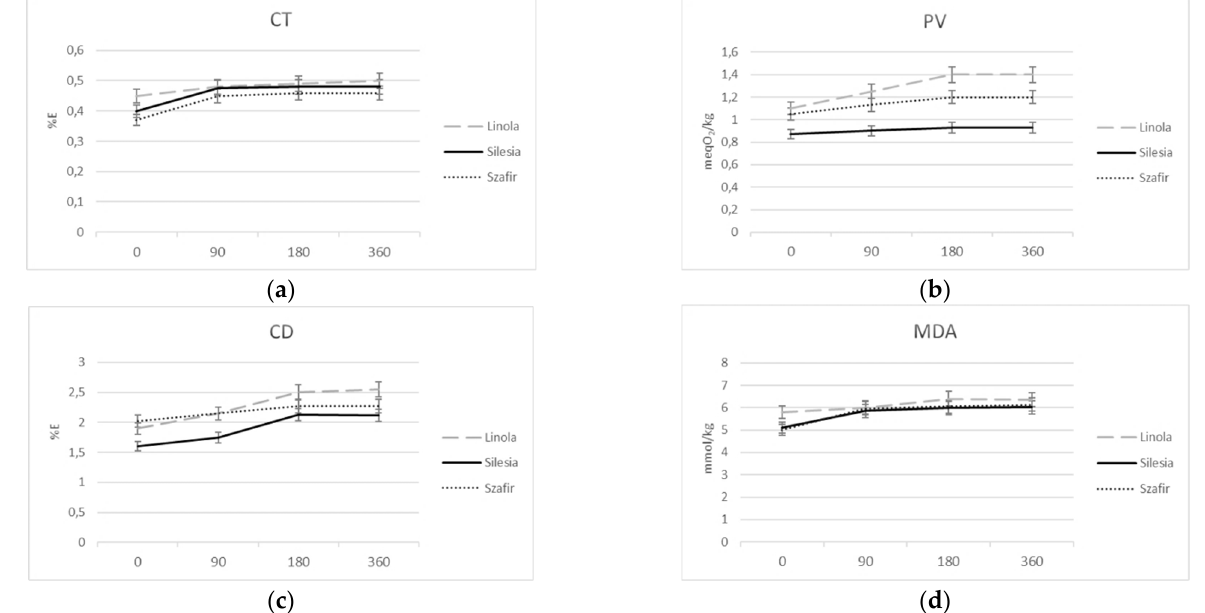
Figure 1. Fluctuation of primary and secondary oxidation products: ( a )—conjugated trienes (CT) ( b )—peroxide value (PV), ( c )—conjugated dienes (CD),and secondary oxidation products: ( d )—malondialdehyde (MDA) when the oil is stored in the refrigerator (4 °C) for 160 days. All results are statistically significant ( p < 0.05).